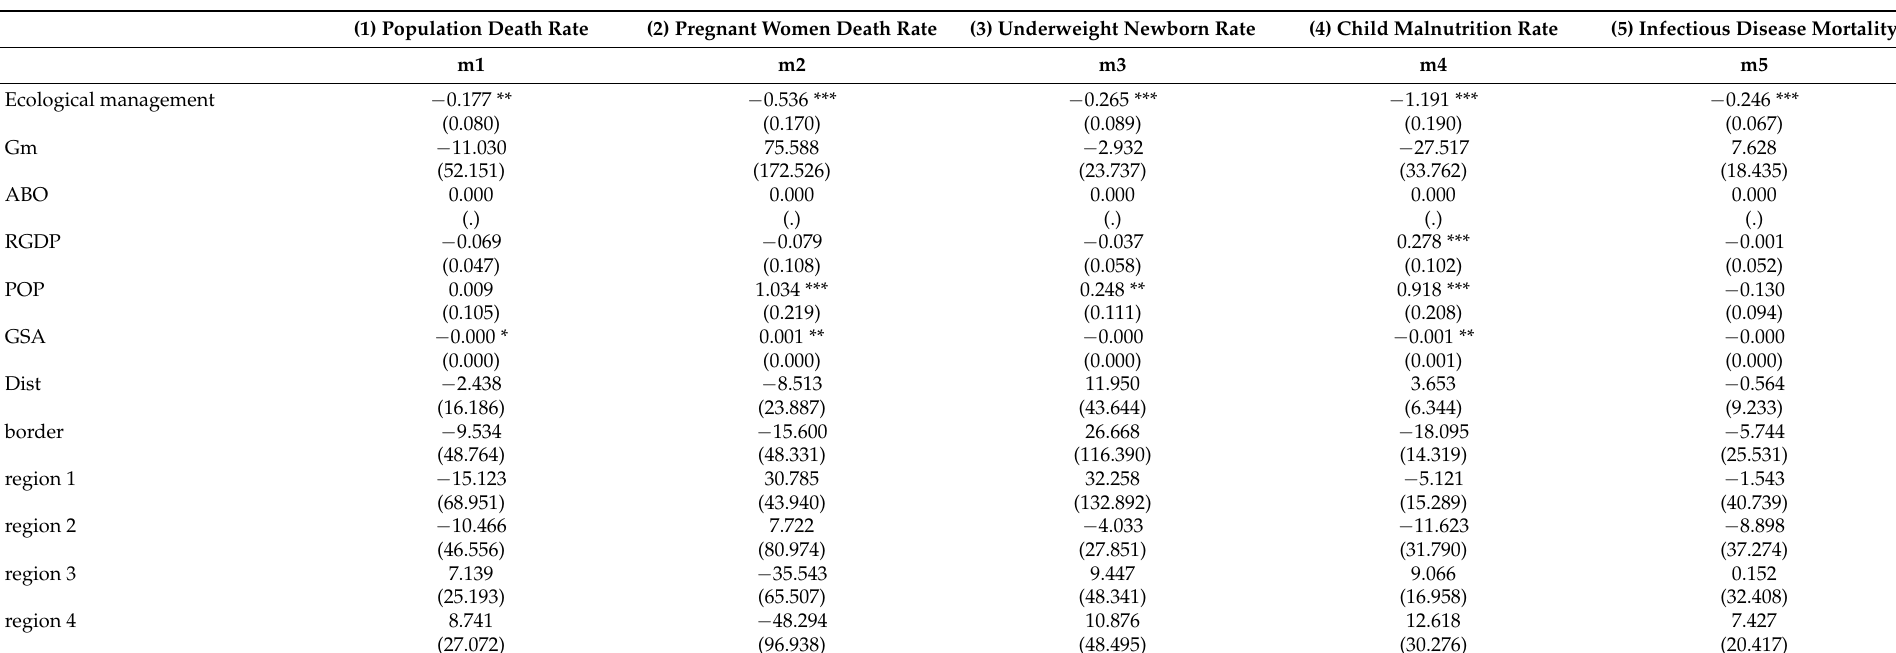
Table 4. Extended results of sys-GMM